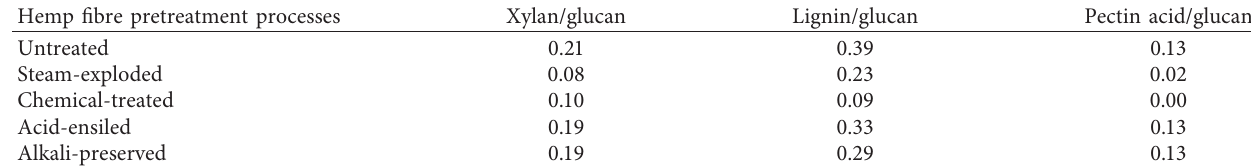
Table 3: Ratio content of xylan to glucan, lignin to glucan, and pectin acid to glucan in various hemp samples [76]. Hemp fibre pretreatment